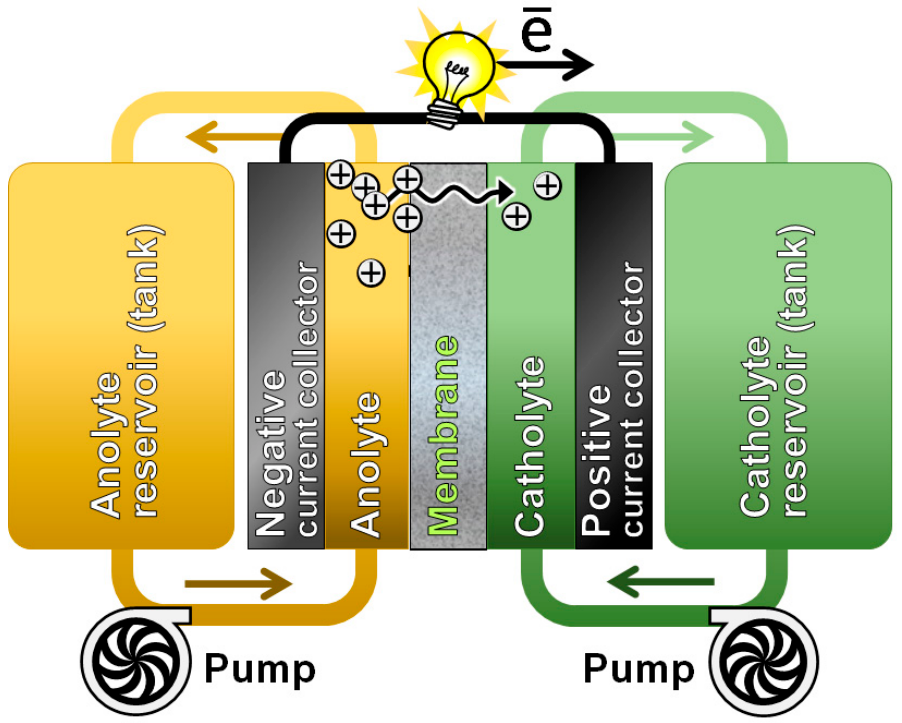
Figure 1. Schematic of a typical redox flow battery.